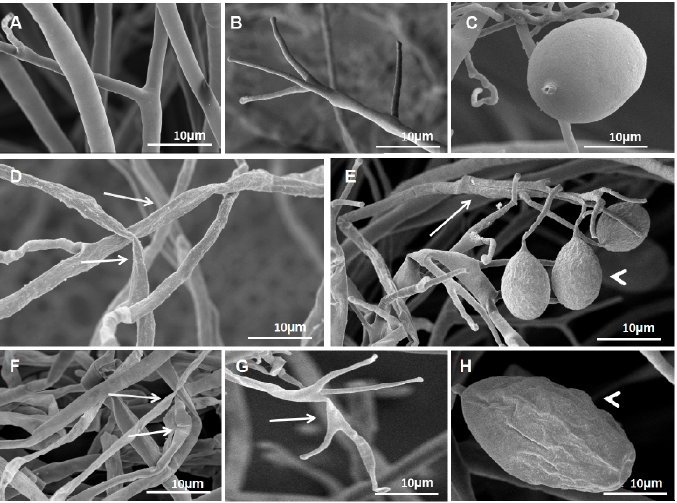
Figure 3. S. fimicarius BWL-H1 volatiles caused morphological changes in P. litchii hyphae, sporangiophores and sporangia. ( A – C ) untreated control; ( D – E ) culture fumigated with 40 g/L wheat seed culture of S. fimicarius BWL-H1; ( F – H ) culture fumigated with 100 g/L wheat seed culture of S. fimicarius BWL-H1. Arrows denote shrinking or distorted mycelia and sporangiophores, and arrowhead for deformed sporangia.